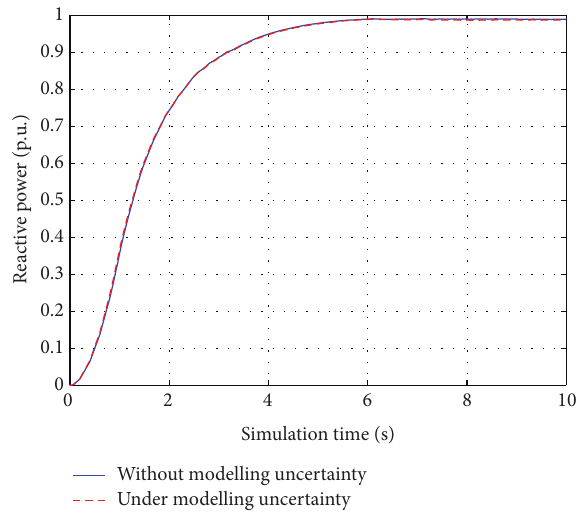
Figure 5: Adaptive controller tracking